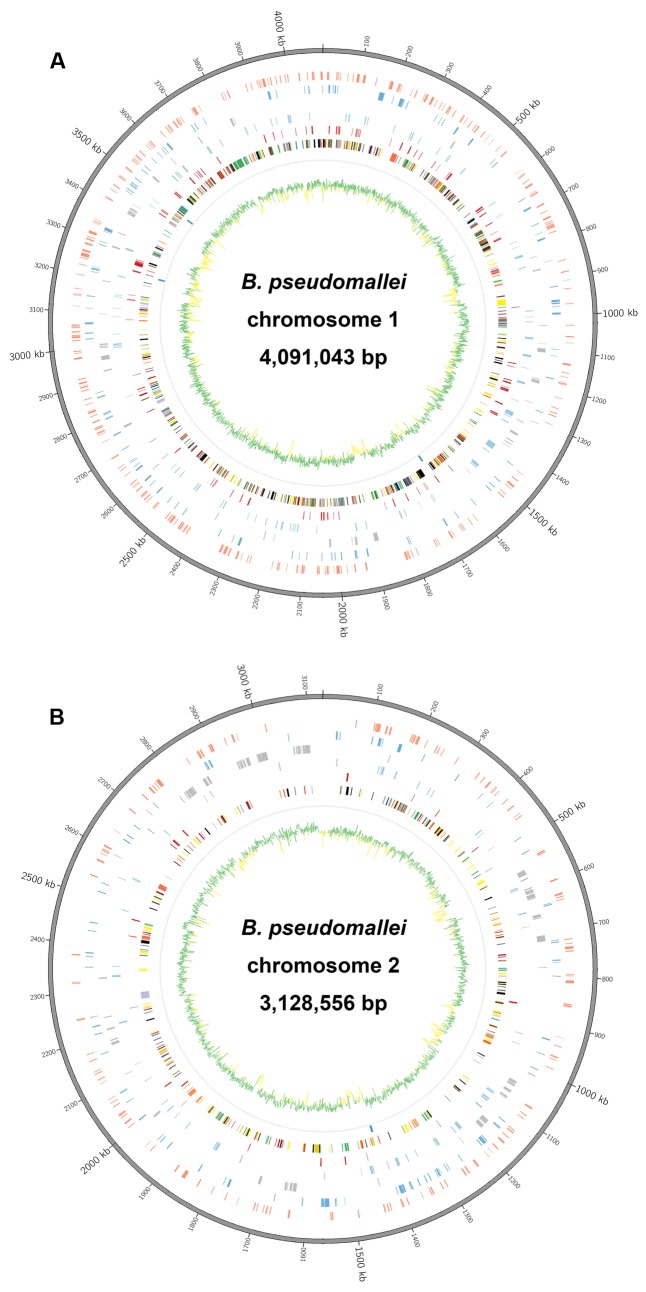
Circular representation of Burkholderia pseudomallei reference genome obtained by hybrid assembly. (A) Chromosome I and (B) chromosome II. CDS on each chromosome was categorized according to SEED Subsystems of Rapid Annotations using Subsystems Technology (RAST). List of tracks (from inside to outside): G+C content (green >68%, yellow <68%), ribosomal operons (dark blue), Protein Metabolism (dark red), Carbohydrates (light blue), Membrane Transport (light gray), Amino Acids and Derivatives (blue), CDSs classified into more than one category (light red), reference genome sequence (gray).